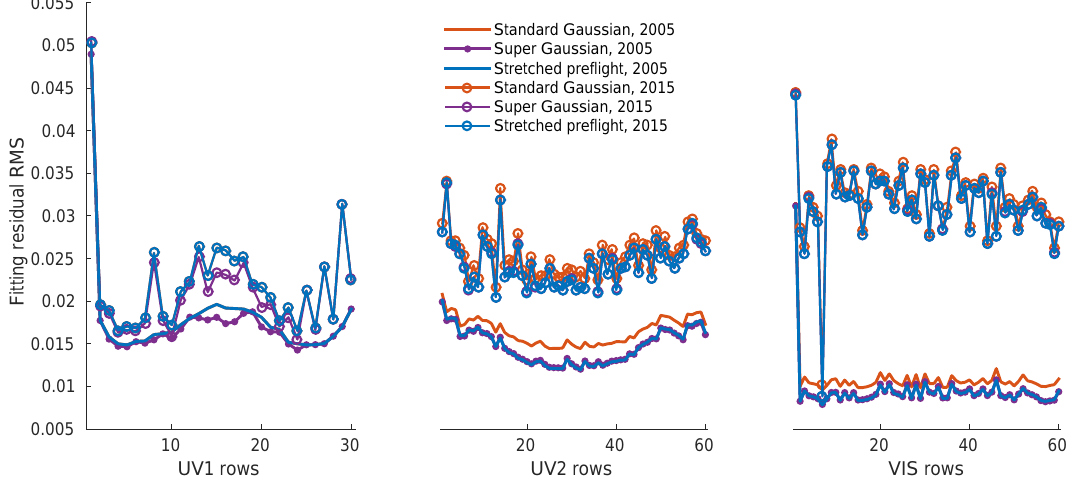
Figure A3. The residual RMS when fitting different slit functions over the OMI UV1, UV2, and VIS bands. The lines without circles are fitting results using solar spectra averaged over 2005; the lines with circles are fitting results using solar spectra averaged over